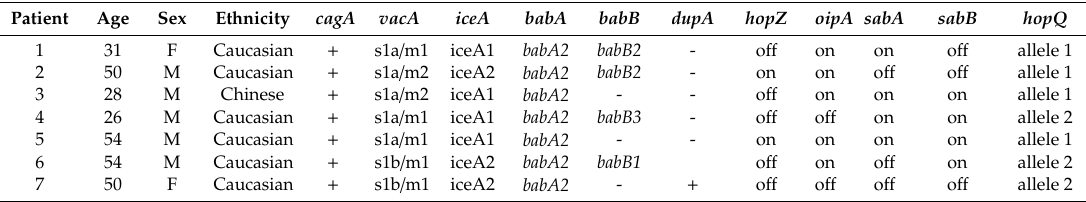
Table 3. The combination of virulence factors in seven presumably highly virulent H. pylori